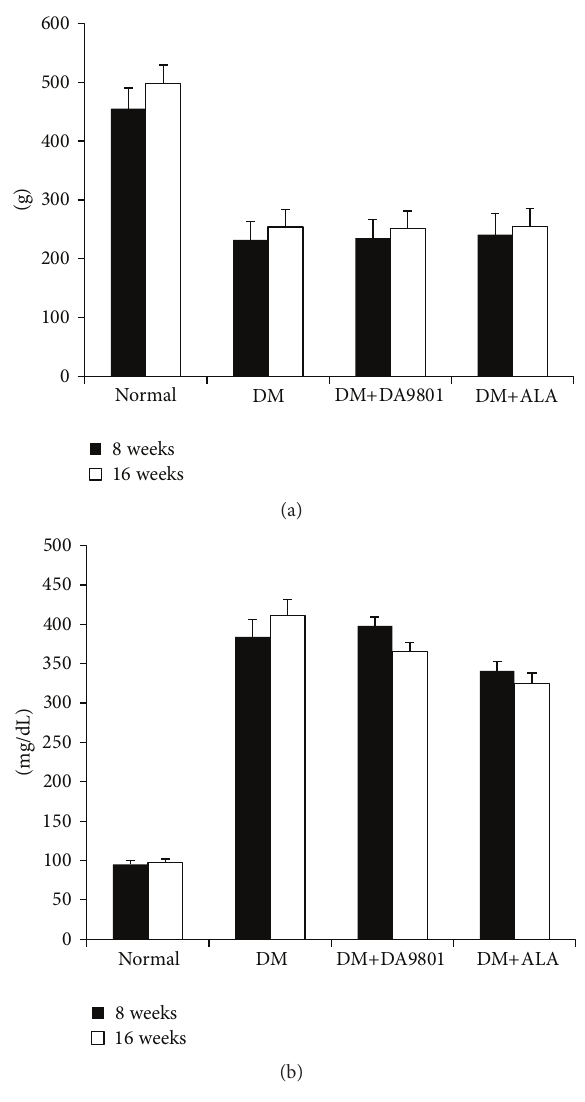
Figure 1: Body weight (a) and blood glucose levels (b) of the experimental groups. Body weight was increased gradually in normal glucose rats. In the diabetic groups, however, it was not increased irrespective of DA-9801 or ALA treatment. DA-9801 and ALA had no effects on blood glucose levels. Data are presented as means ± SD ( 𝑁 = 10 in each group). ALA: Alpha lipoic acid and DM: